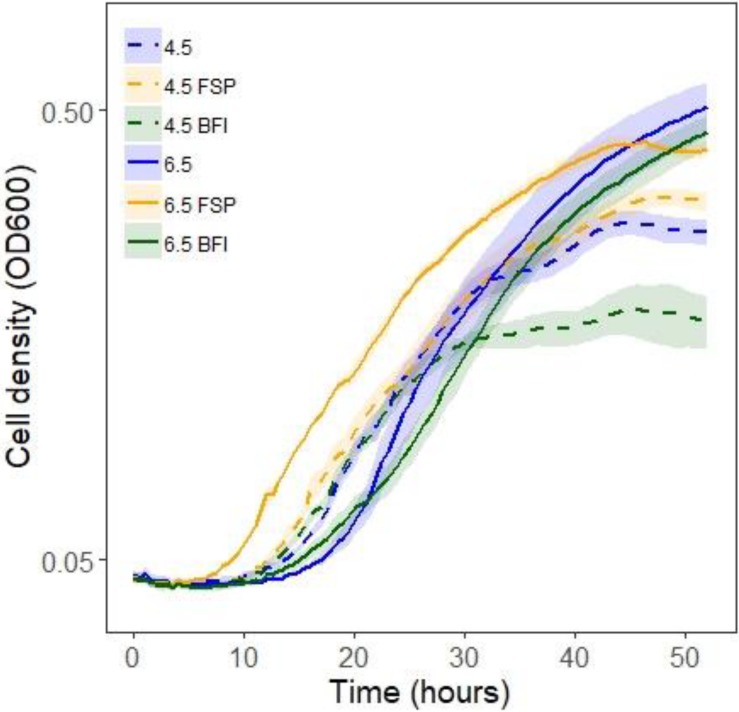
Optical density (OD600) growth data for Burkholderia growing in P20 media and P20 media conditioned by buffering and microbial growth (see legend and Table 3 for details). Line color and texture reflect pH and conditioning, solid and dashed lines reflect pH 6.5 and 4.5, respectively, while blue, yellow, and green lines indicate plain unconditioned media, fungal spent (FSP), and co-cultured bacterial fungal interaction (BFI) conditioned media, respectively.